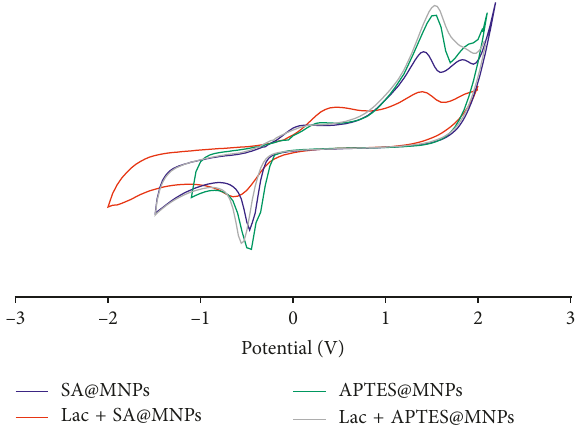
Figure 6: Cyclic voltammograms of APTES@MNPs and SA@ MNPs coated on GCEs at a sweep rate of 20mV/s in 0.05M sodium acetate buffer at pH 5.0 in the absence and presence of